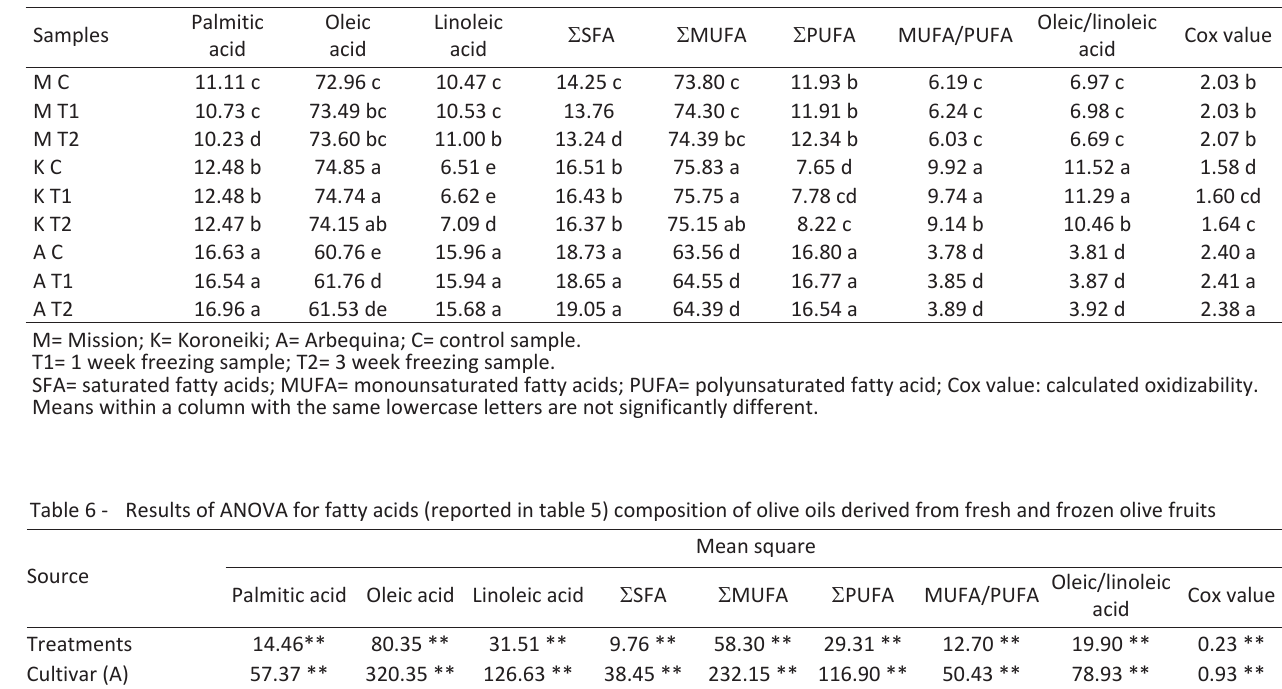
Table 5 - Fatty acid (Palmitic acid, Oleic acid, Linoleic acid, ∑SFA, ∑PUFA, MUFA/PUFA, Oleic/Linoleic and cox value) compositions and comparison of the means with Duncan’s multiple range test at 5%